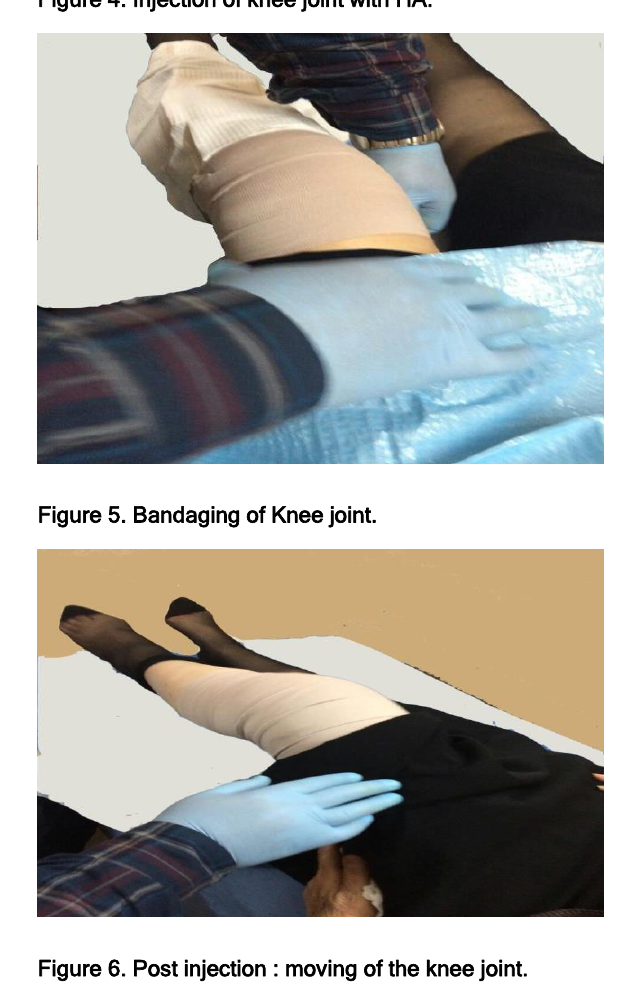
Figure 3.Injection of the knee joint with steroid